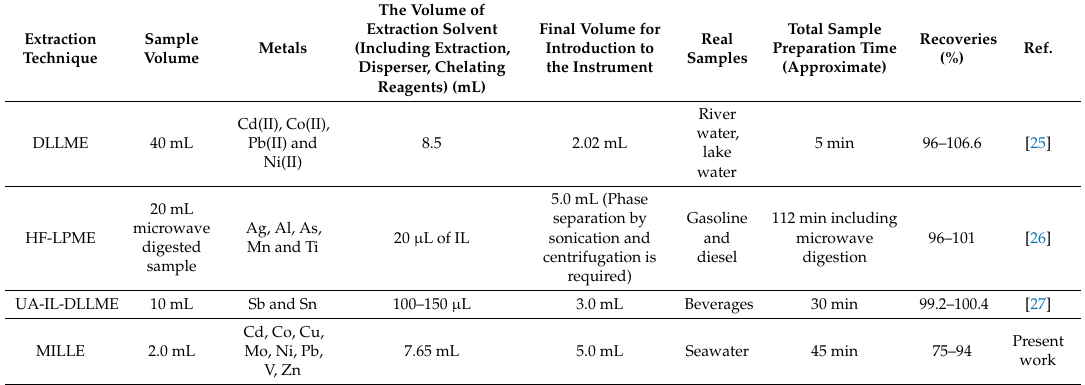
Table 5. Comparison of MILLE with other techniques coupled with ICP-OES in terms of sample and final